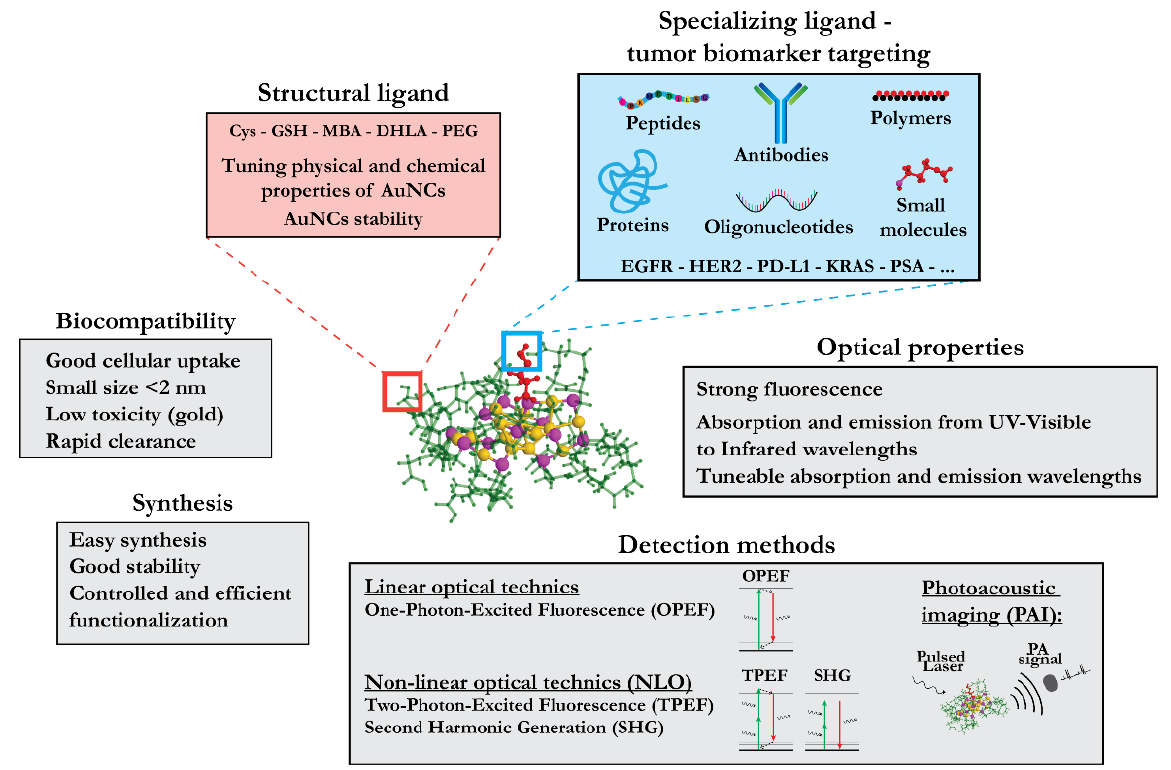
Figure 7. Summarized properties of liganded AuNCs as cancer diagnostics agents.